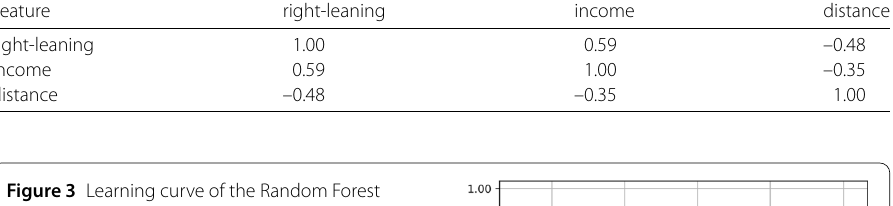
Figure 3 Learning curve of the Random Forest regressor model for the top 25 news outlets in Santiago. Each step represents the average explained variance of 100 iterations of shuffle split cross-validation with 20% of the data for